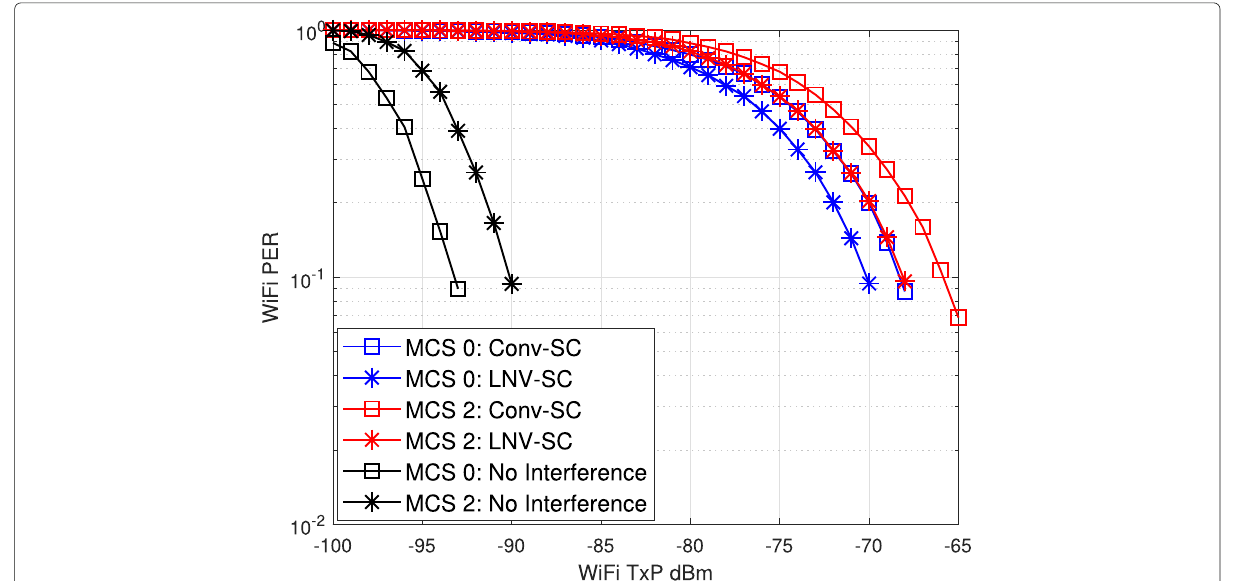
Fig. 13 LNV-SC vs Conv-SC for single-antenna WiFi receiver in the presence of four interferers. LNV-SC achieves more gain in SNR compared to Conv-SC for all the WiFi